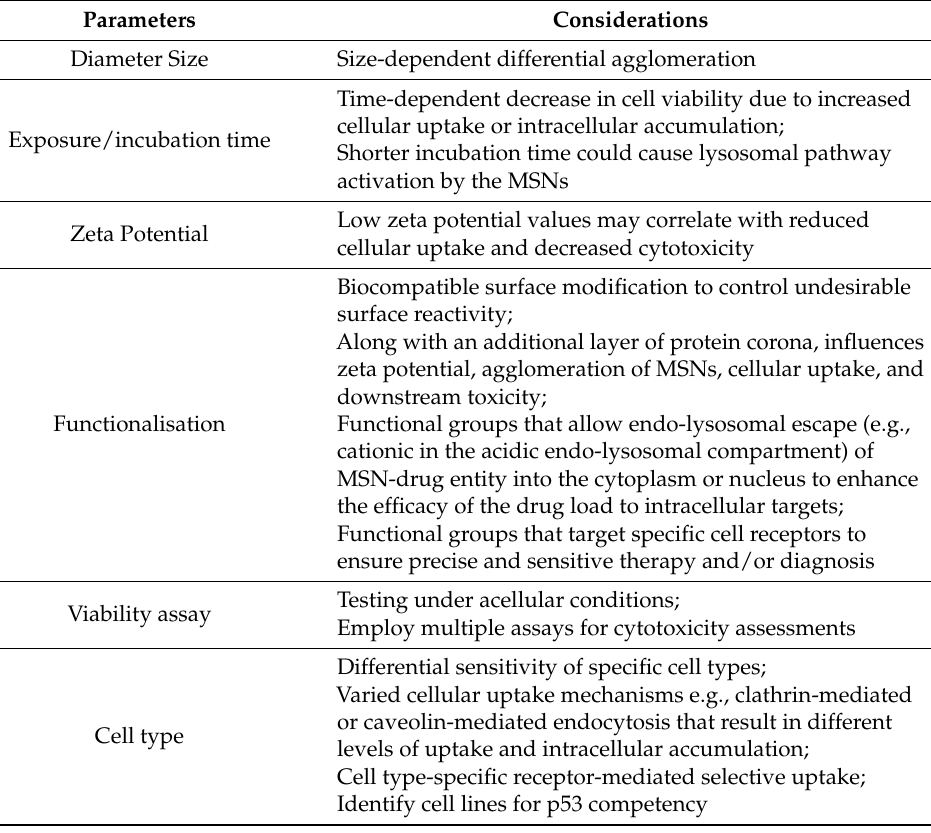
Table 9. Summary of the various parameters assessed in this study and considerations that may influence cytotoxicity